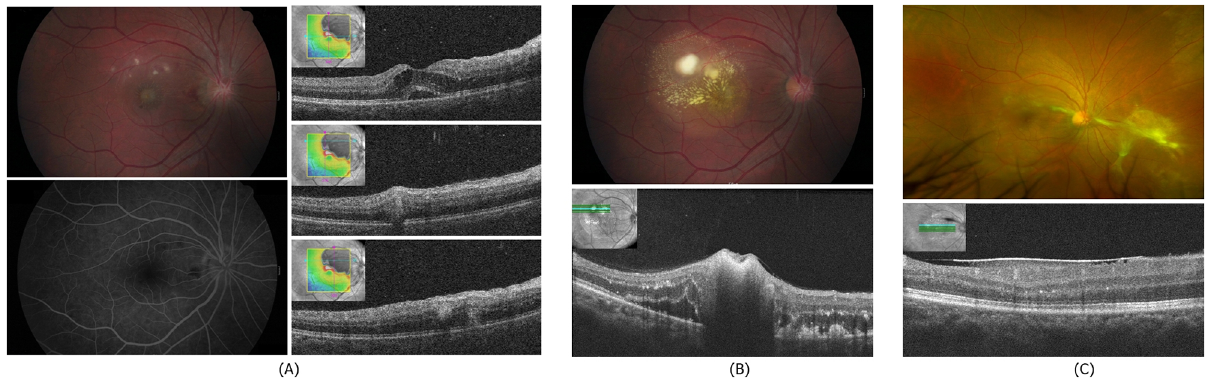
Fig 1. (A) Initial fundus photographs, FAG, and SD-OCT of a 34-year-old male who presented with suddenly decreased vision for 2 days in the right eye. The fundus finding in the right eye shows retinal hemorrhage around the disc edema, multiple retinal granulomatous lesions, and macular edema. Using FAG, there was no abnormal finding except blocked fluorescence at the granuloma and a hemorrhage lesion. SD-OCT shows that granulomas were located across the inner and outer retina. (B) Fundus photograph and SD-OCT at the 3-month recurrence. When compared with the initial visit, larger granulomas accompanying exudation around the lesion were present. (C) Fundus photograph and SD-OCT at 6 months after the initial visit. The location of granulomas changed to the nasal retina, but the ERM remained superior to the fovea. FAG, fluorescein angiography; SD-OCT, spectral domain-optical coherence tomography; ERM, epiretinal